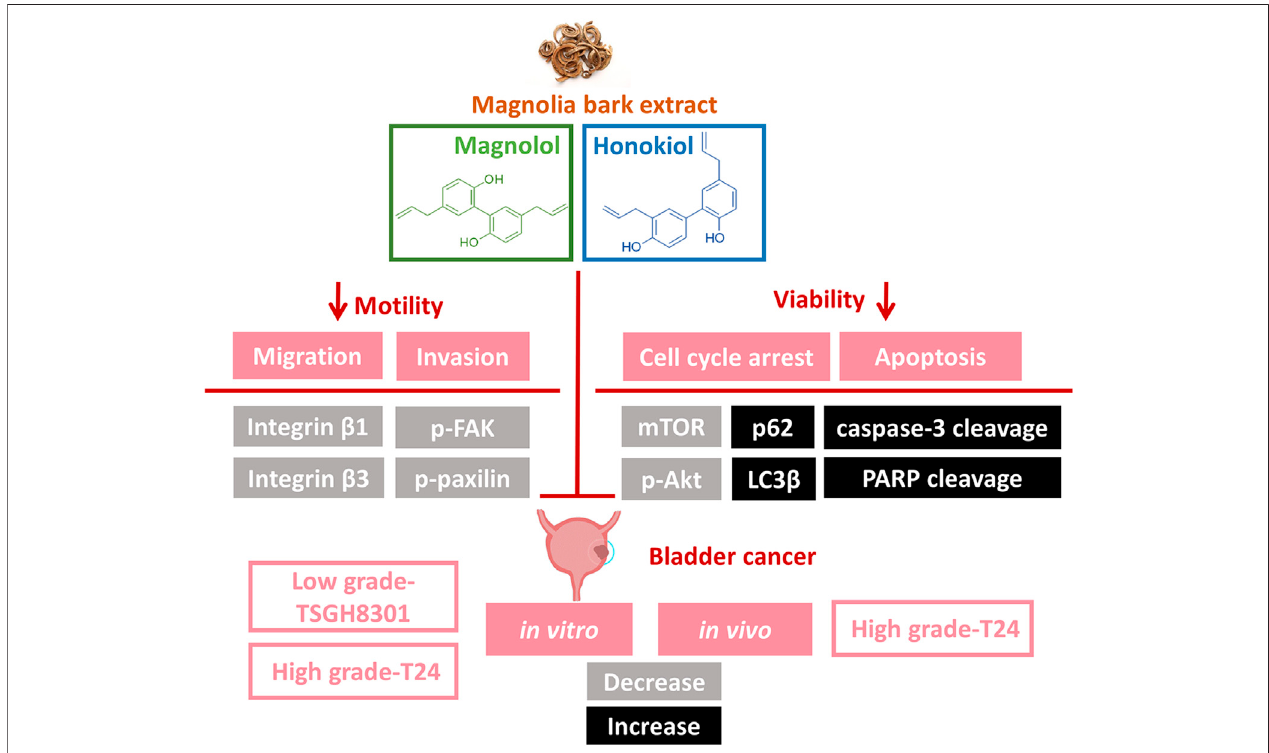
FIGURE7| Illustration ofHono-and Mag-induced apoptosis andmigrationsignaling pathwaysinbladder cancercells. ThecombinationofHonoand Magcaused cell cycle arrest and caspase-dependent apoptosis. In addition, Hono and Mag reduced bladder cancer migration through inhibition of the focal adhesive complex.